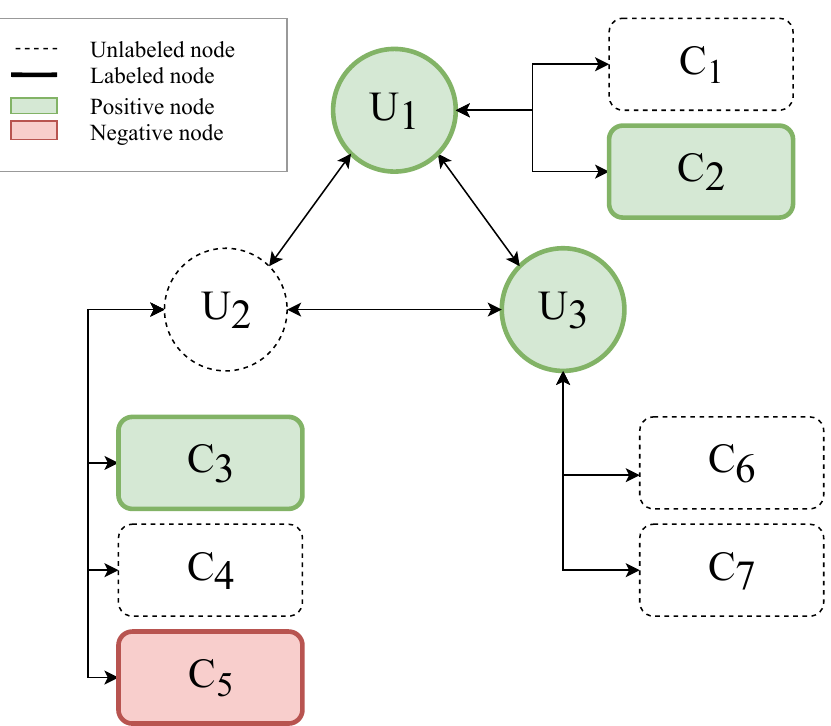
Figure 2. Problem definition. The task is to predict the missing labels.